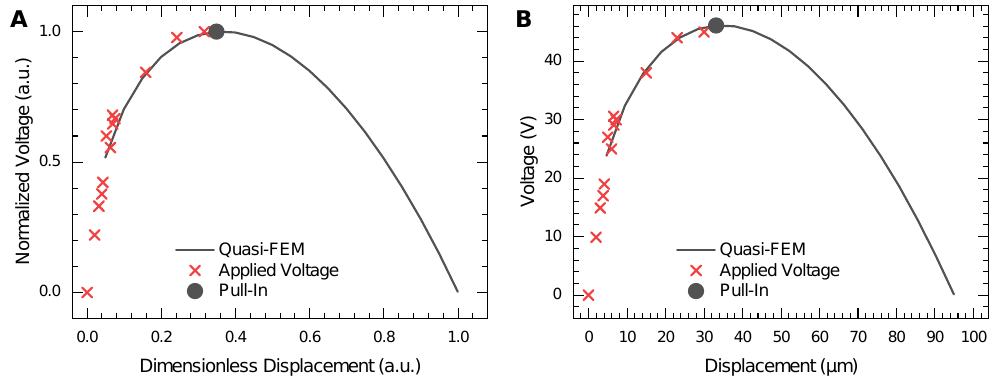
Figure 9. Results of modeling for PM with a 3200µm side length and a thickness of 25µm Al: ( A ) normalized voltage vs. dimensionless displacement; ( B ) voltage vs. displacements in absolute values.